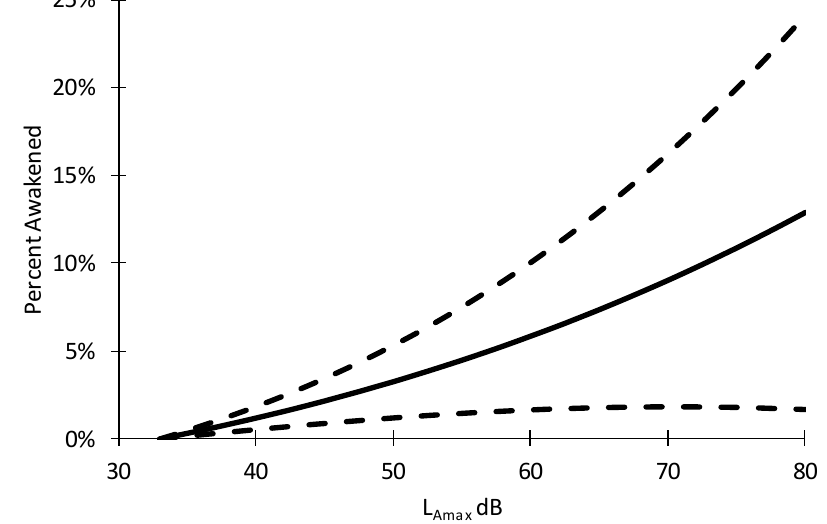
Figure 7. The unadjusted probability of an additional awakening induced by aircraft noise depending on indoor maximum sound pressure level L Amax (slow time weighting) for PHL International Airport. Dashed lines indicate 95% confidence intervals.